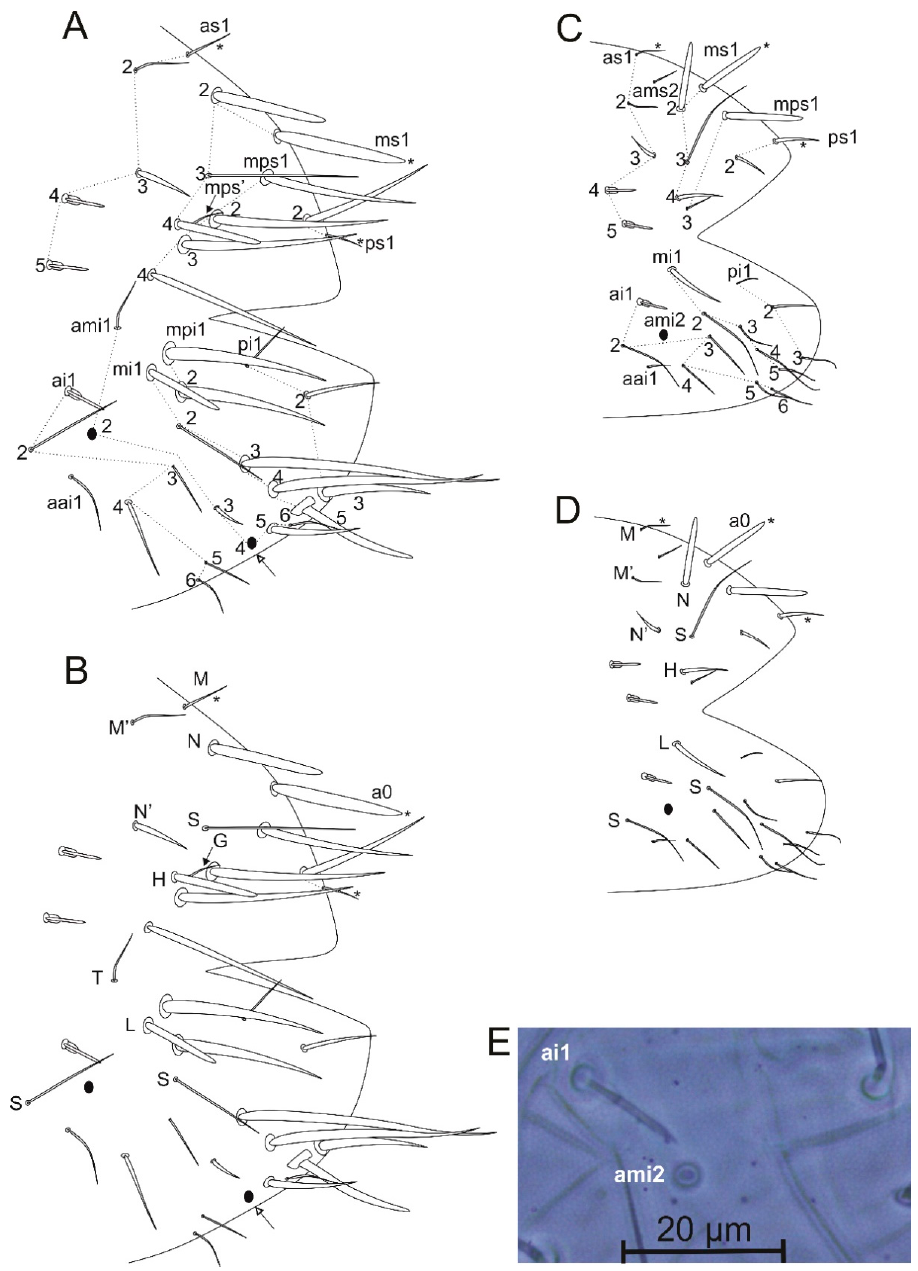
Figure 23. Calvatomina gladiata sp. nov. small abdomen (lateral view): ( A ) female (labels following Betsch [31]); white arrow indicates an element present or absent; ( B ) female (labels following Nayrolles and Betsch [18]); ( C ) male (labels following Betsch [31]); ( D ) male (labels following Nayrolles and Betsch [18]); ( E ) oval organ ( ami2 ) and cup sensillum ( ai1 ) of female.